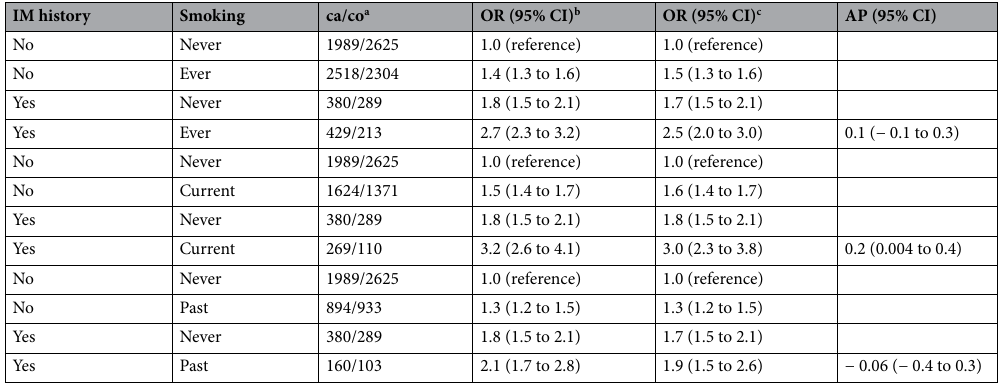
Table 5. OR with 95% CI of developing MS among subjects categorized by IM history and smoking, stratified by EBNA1 IgG status. AP with 95% CI between past IM and smoking. a Number of exposed cases and controls b Adjusted for age, sex, residential area, study, and ancestry c Adjusted for age, sex, residential area, study, ancestry, adolescent body mass index, EBNA1 status, DRB1*1501, DRB1*0301, DRB1*1303, DRB1*0801, A*0201, B*4402, B*3801, B*5501, DQA1*0101, DQB1*0302, DQB1*0301, homozygote correction for DRB1*1501, DRB1*0301, and A*0201. Adjusted for age, sex, residential area, study, ancestry, adolescent body mass index, DRB1*1501, DRB1*0301, DRB1*1303, DRB1*0801, A*0201, B*4402, B*3801,